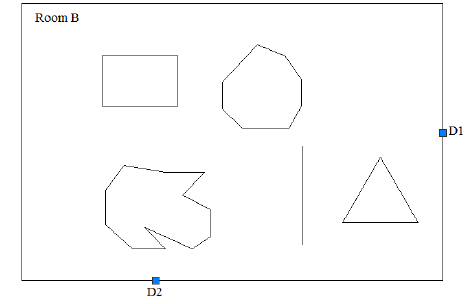
Figure 9. Simplified plan of Room B